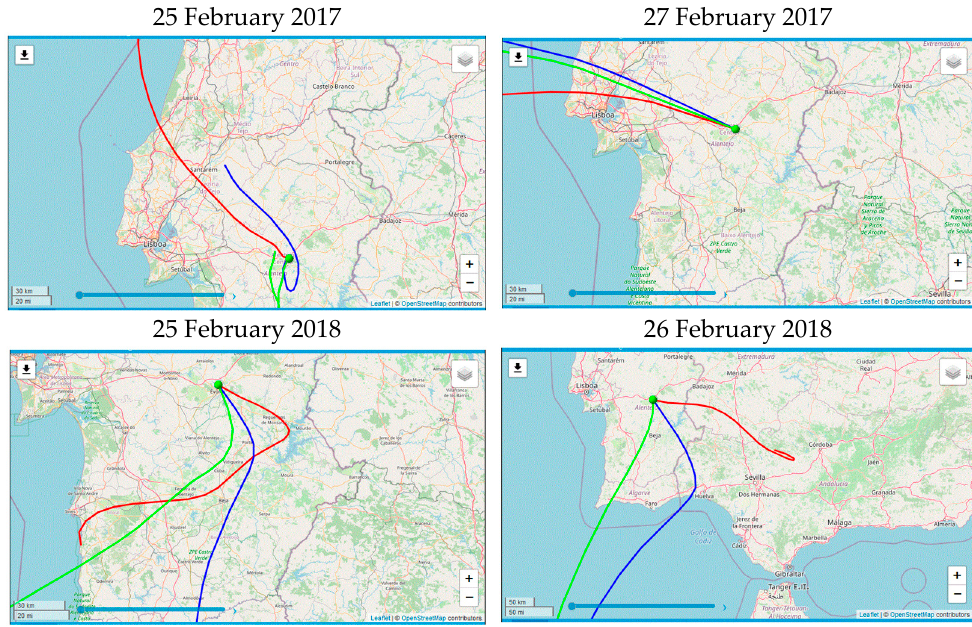
Figure 7. Air mass back trajectory for 2017 and 2018 at 10:00 UTC; height 100 m—red line, height 500 m—blue line and height 1000 m—green line.